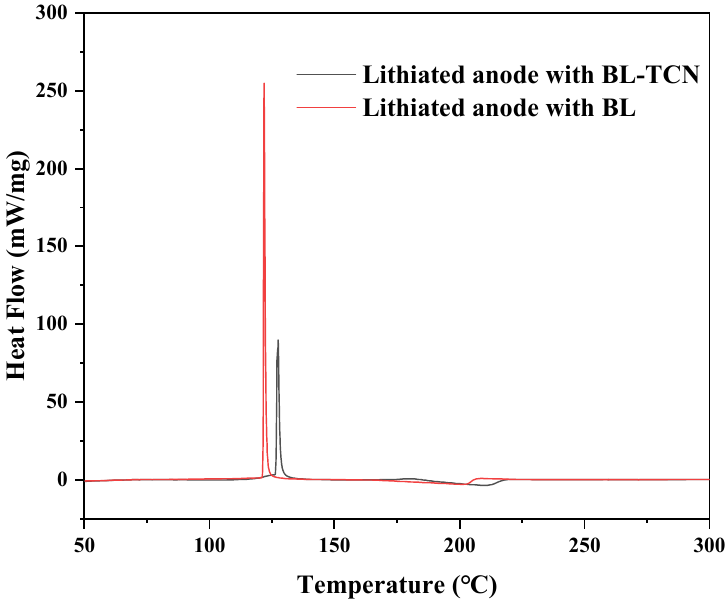
Figure 4. DSC curve of lithiated anode mixture with various electrolytes at 6 ◦ C/min. Table 1 presents the critical thermokinetic parameters of the admixtures of different electrolytes and anodes, which visualize the thermal hazards of lithiated anode powders in different electrolytes. For example, the BL electrolyte with a lithiated anode as a blank control sample had more severe exothermic peaks, earlier exothermic temperature, and larger ∆ H . However, following the inclusion of additive TCN, the exothermic peak of the anode mixed electrolyte became smaller, and the thermal hazard was significantly reduced. Table 1. DSC thermokinetic parameters of different samples at a heating rate of 6 ◦ C/min. Sample Lithiated anode with